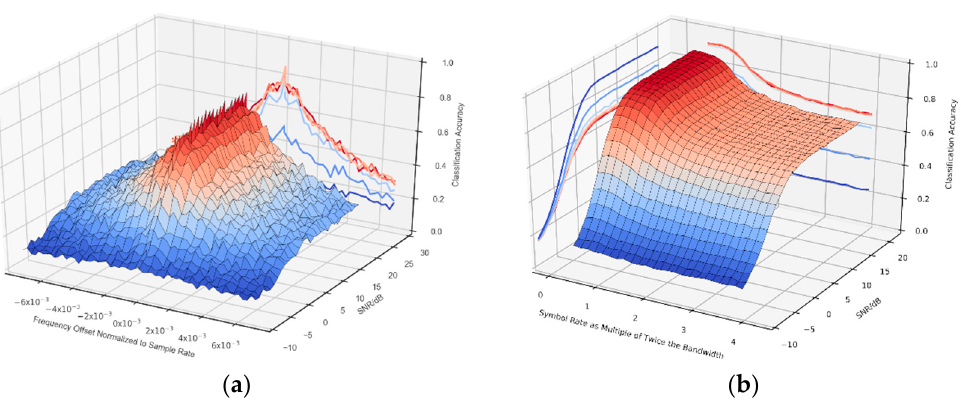
Figure 7. Overall classification accuracy of the classifier with SSTM for various training scenarios vs. frequency offset and SNR. ( a ) CFO1; ( b ) SRO1.